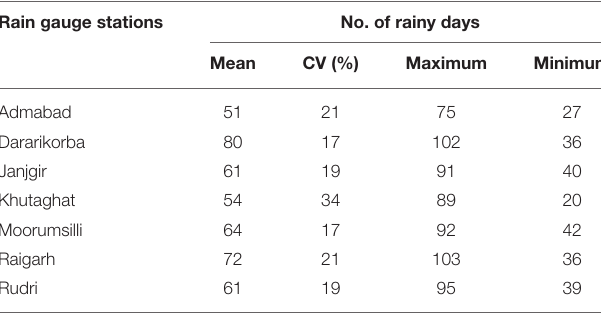
TABLE 2 | Analysis of rainy days of seven rain gauge stations in the study area. Rain gauge stations No. of rainy